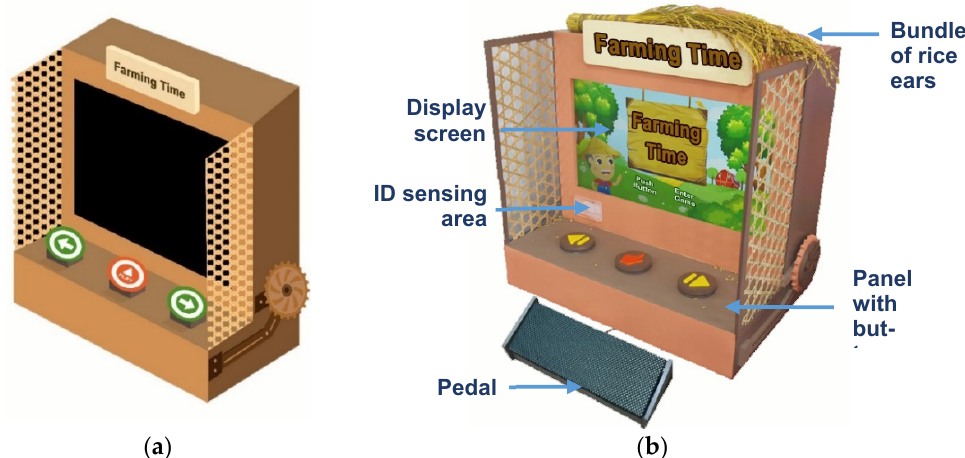
Figure 1. Proposed interactive system simulating an old-time pedal-operated rice threshing machine ( a ) An illustration of the proposed system. ( b ) The actual constructed system.